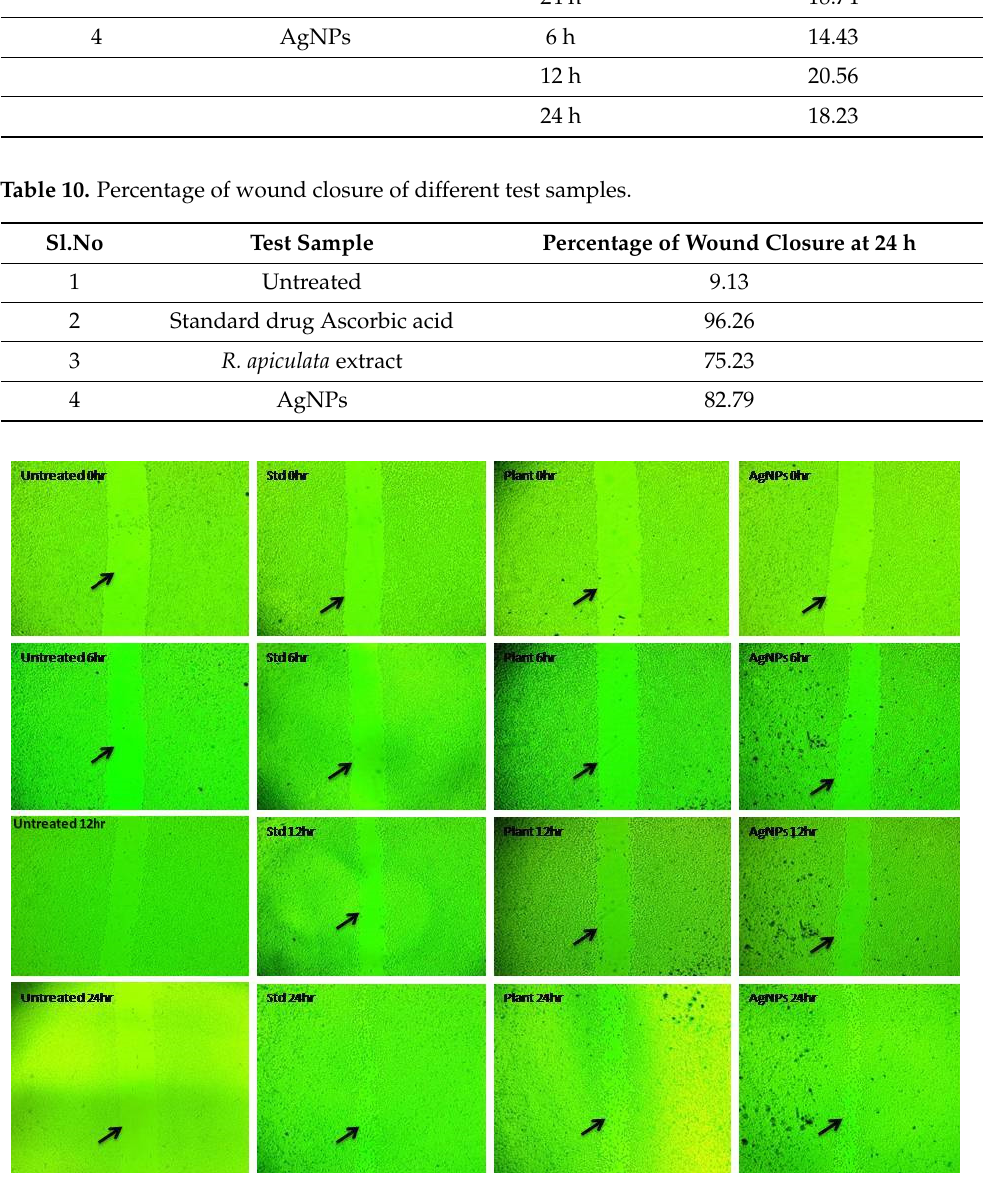
Figure 12. Microscopical images illustrating the ability of R. apiculata to heal wounds (in vitro). Images were taken at 0, 6, 12, and 24 h after mice fibroblast cells were cultured in the presence or absence of test and standard drugs.